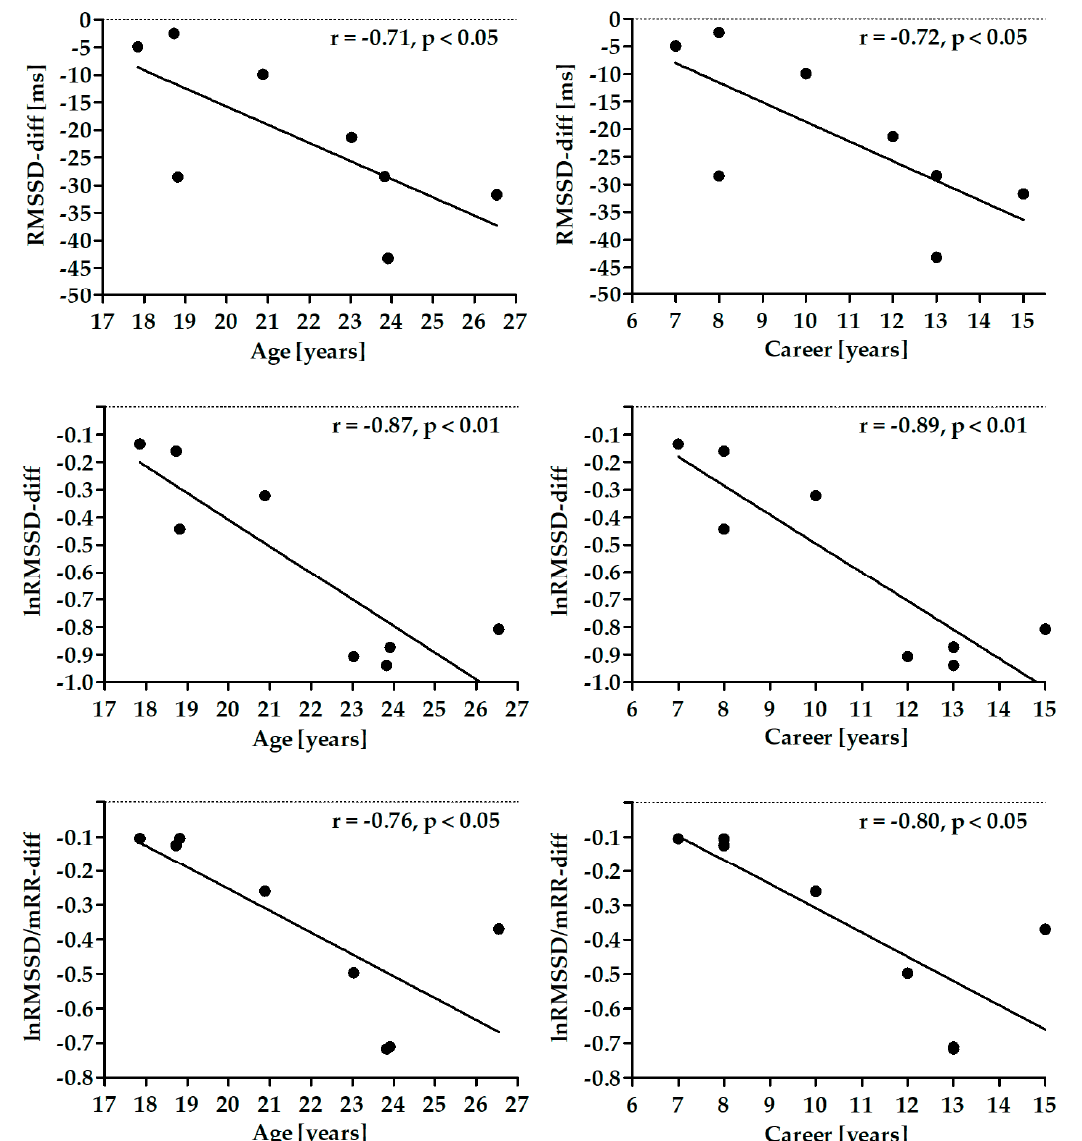
Figure 3. Correlation between differences in root mean square of successive differences (RMSSD) parameters and athlete’s age and career time.